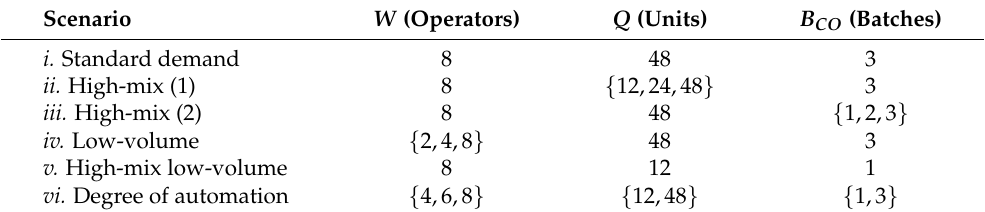
Table 8. Simulation scenarios and design parameters analyzed.